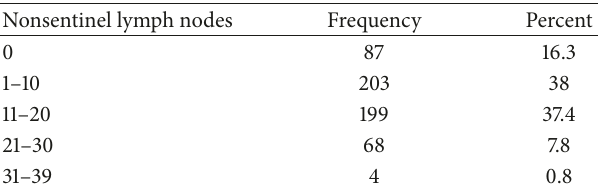
Table 5: Nonsentinel lymph nodes obtained in sentinel lymph node positive patients.